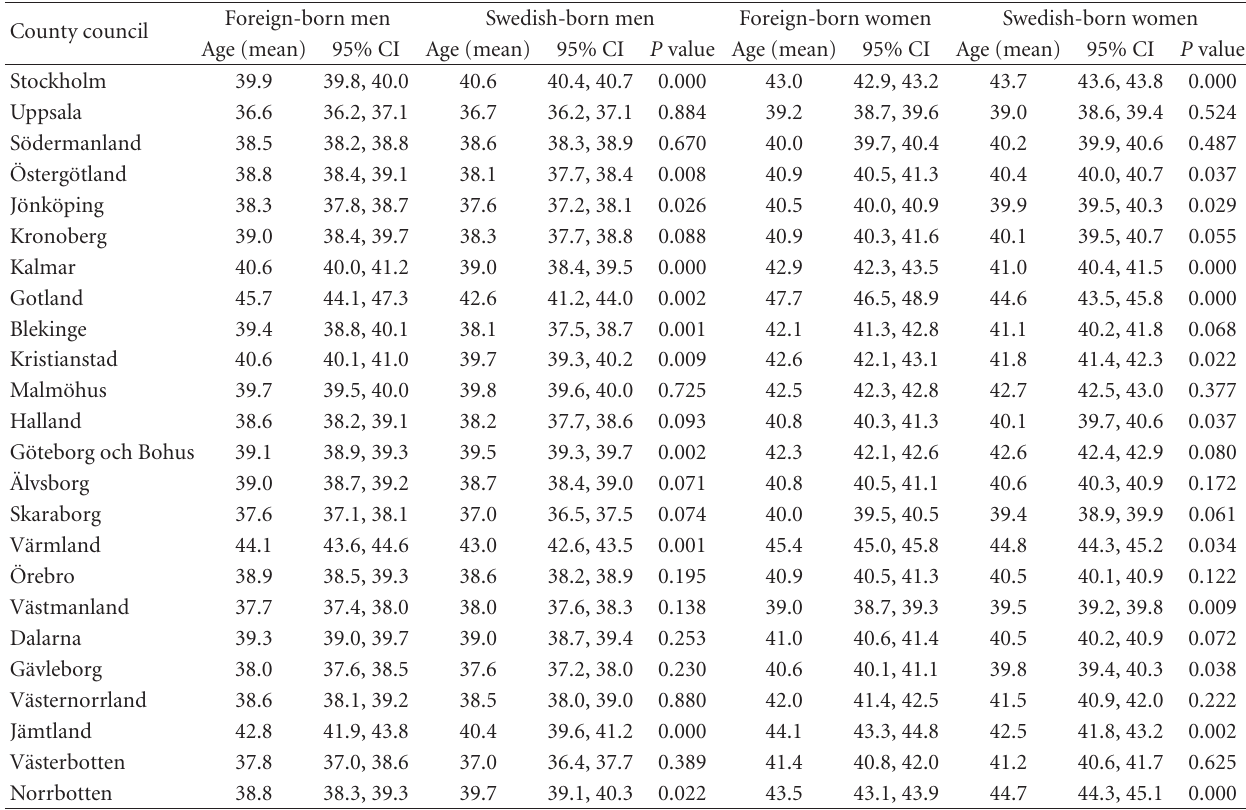
Table 3: Population in relation to age (1970) and latest county council of